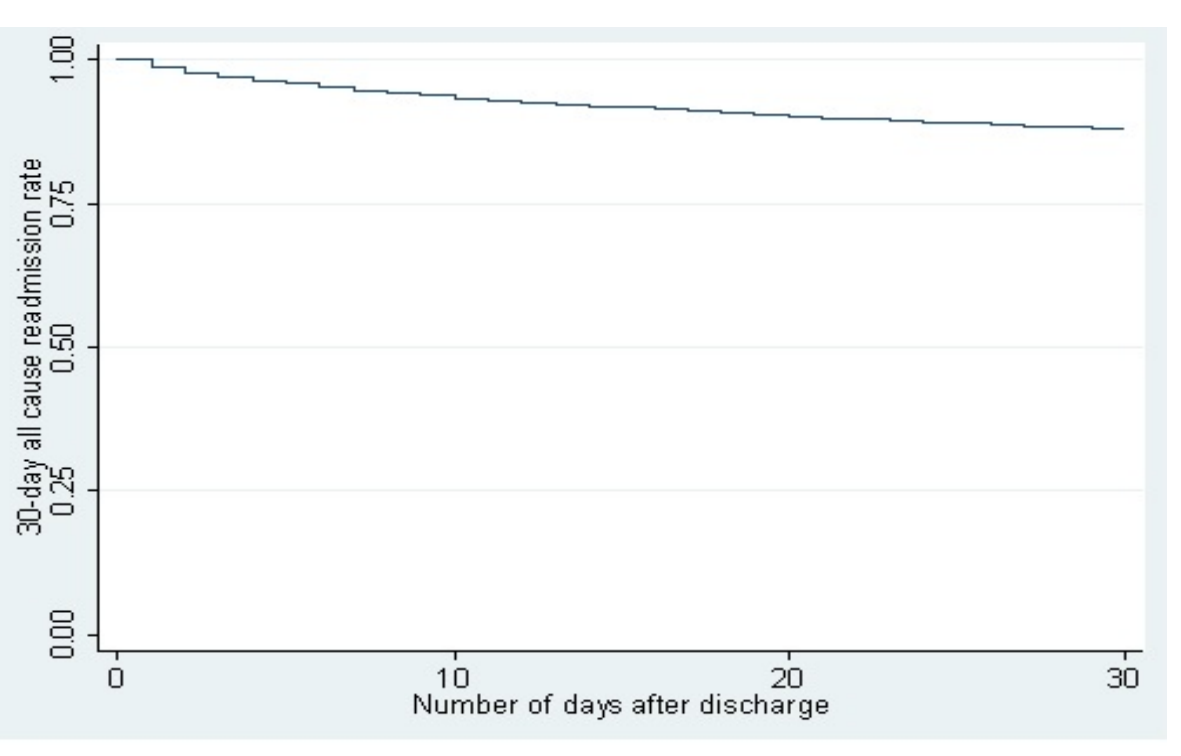
Figure 2. Of 93,140 patients, 92,253 were discharged alive of which 11,292 (12.24%) were readmitted in 30 days. Figure 2 shows Kaplan–Meier survival curve.